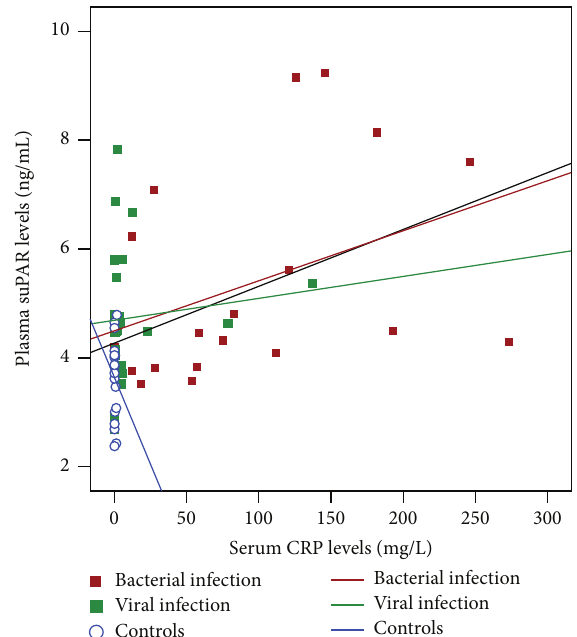
Figure 2: Correlations between plasma suPAR and serum CRP levels on admission. Red box, neonates with bacterial infections; green box, neonates with viral infections; blue circle, controls. The lines represent the regression slope separately for the groups of bacterial (red line; 𝑃 = 0.02 ), viral infection (green line; 𝑃 = 0.45 ), controls (blue line; 𝑃 = 0.48 ), and for the entire study population (—; 𝑃 = 0.001